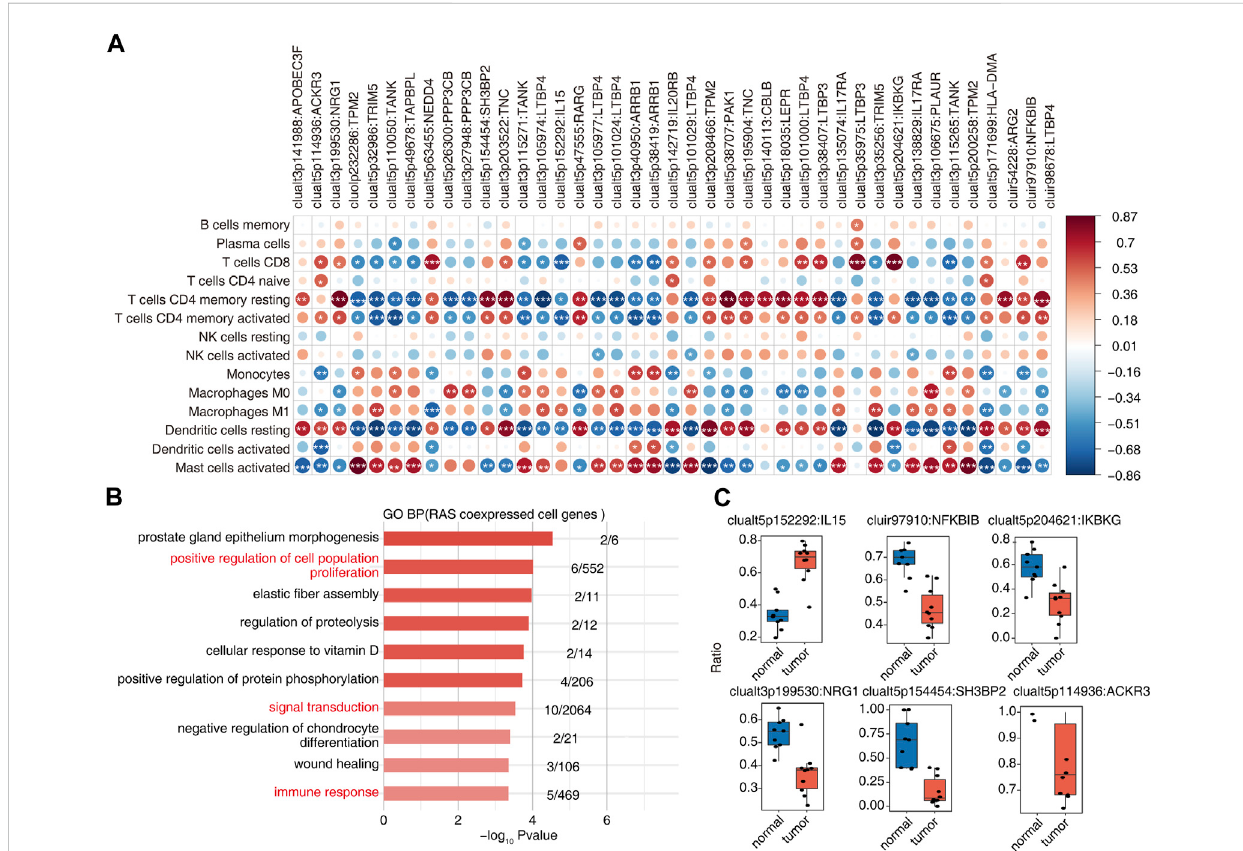
FIGURE 3 Identi fi cation of immune-associated osteosarcoma RAS. (A) The dot plot demonstrated the correlations between each immune microenvironment in fi ltration cell type and each dysregulated RBP regulator. Different colors indicate correlation of the immunocyte – RBP regulator, and signi fi cant regulators were labeled with star. *, p < =0.05; **, p < =0.01; ***, p < =0.001. (B) The top 10 most enriched GO terms (biological process) were illustrated for RAS coexpressed cell genes in the tumor vs. normal group. The color scale indicates the row-scaled signi fi cance (-log10 corrected p -value) of the terms. (C) Boxplot showing the splicing ratio of clualt3p199530 NRG1, clualt5p154454 SH3BP2, clualt5p114936 ACKR3, clualt5p152292 IL15, cluir97910 NFKBIB, and clualt5p204621 IKBKG. * p < 0.001, ** p < 0.001, and *** p <